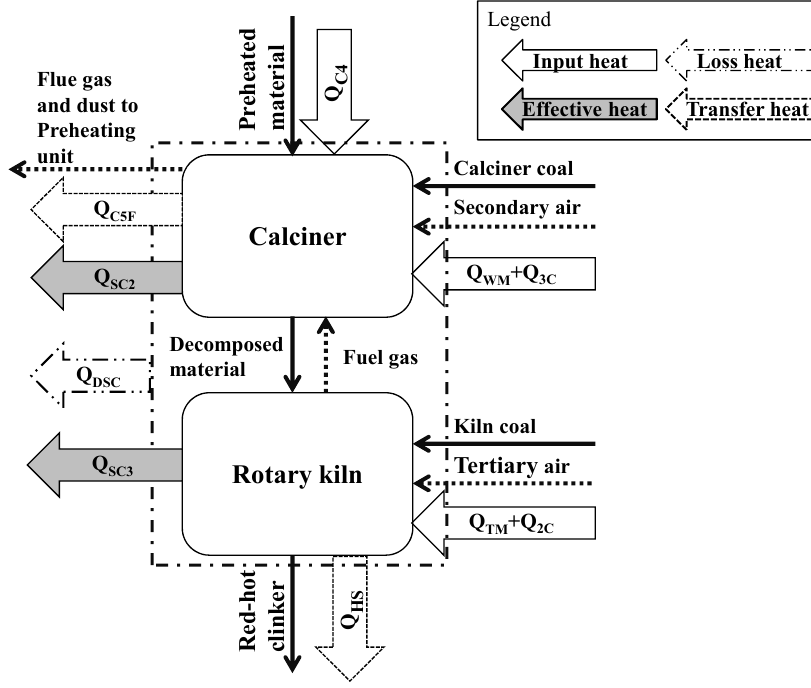
Figure 4. Heat flow modelling of the Decomposition and Clinker Calcination unit.